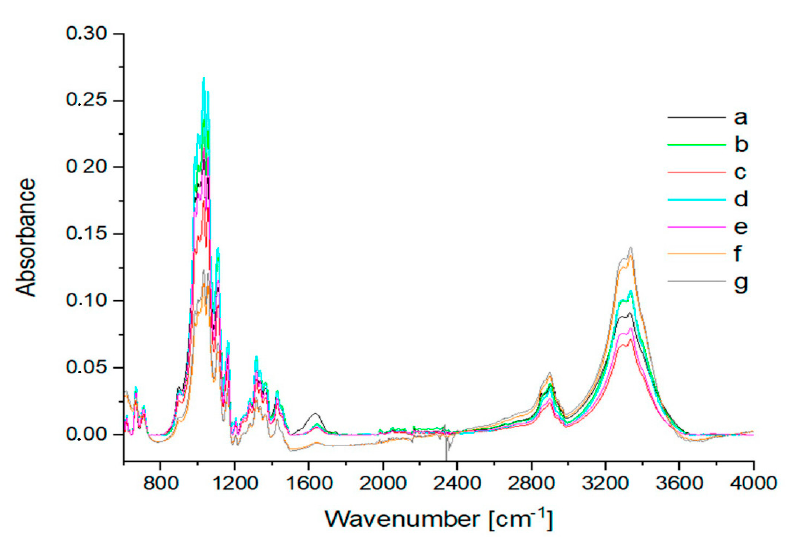
Figure 12. IR spectra of ( a ) washed cotton and cotton treated at 120 °C with 2% H 2 SO 4 for various reaction times: ( b ) 1 h; ( c ) 2 h; ( d ) 3 h; ( e ) 4 h; ( f ) 6 h; ( g ) 8 h.